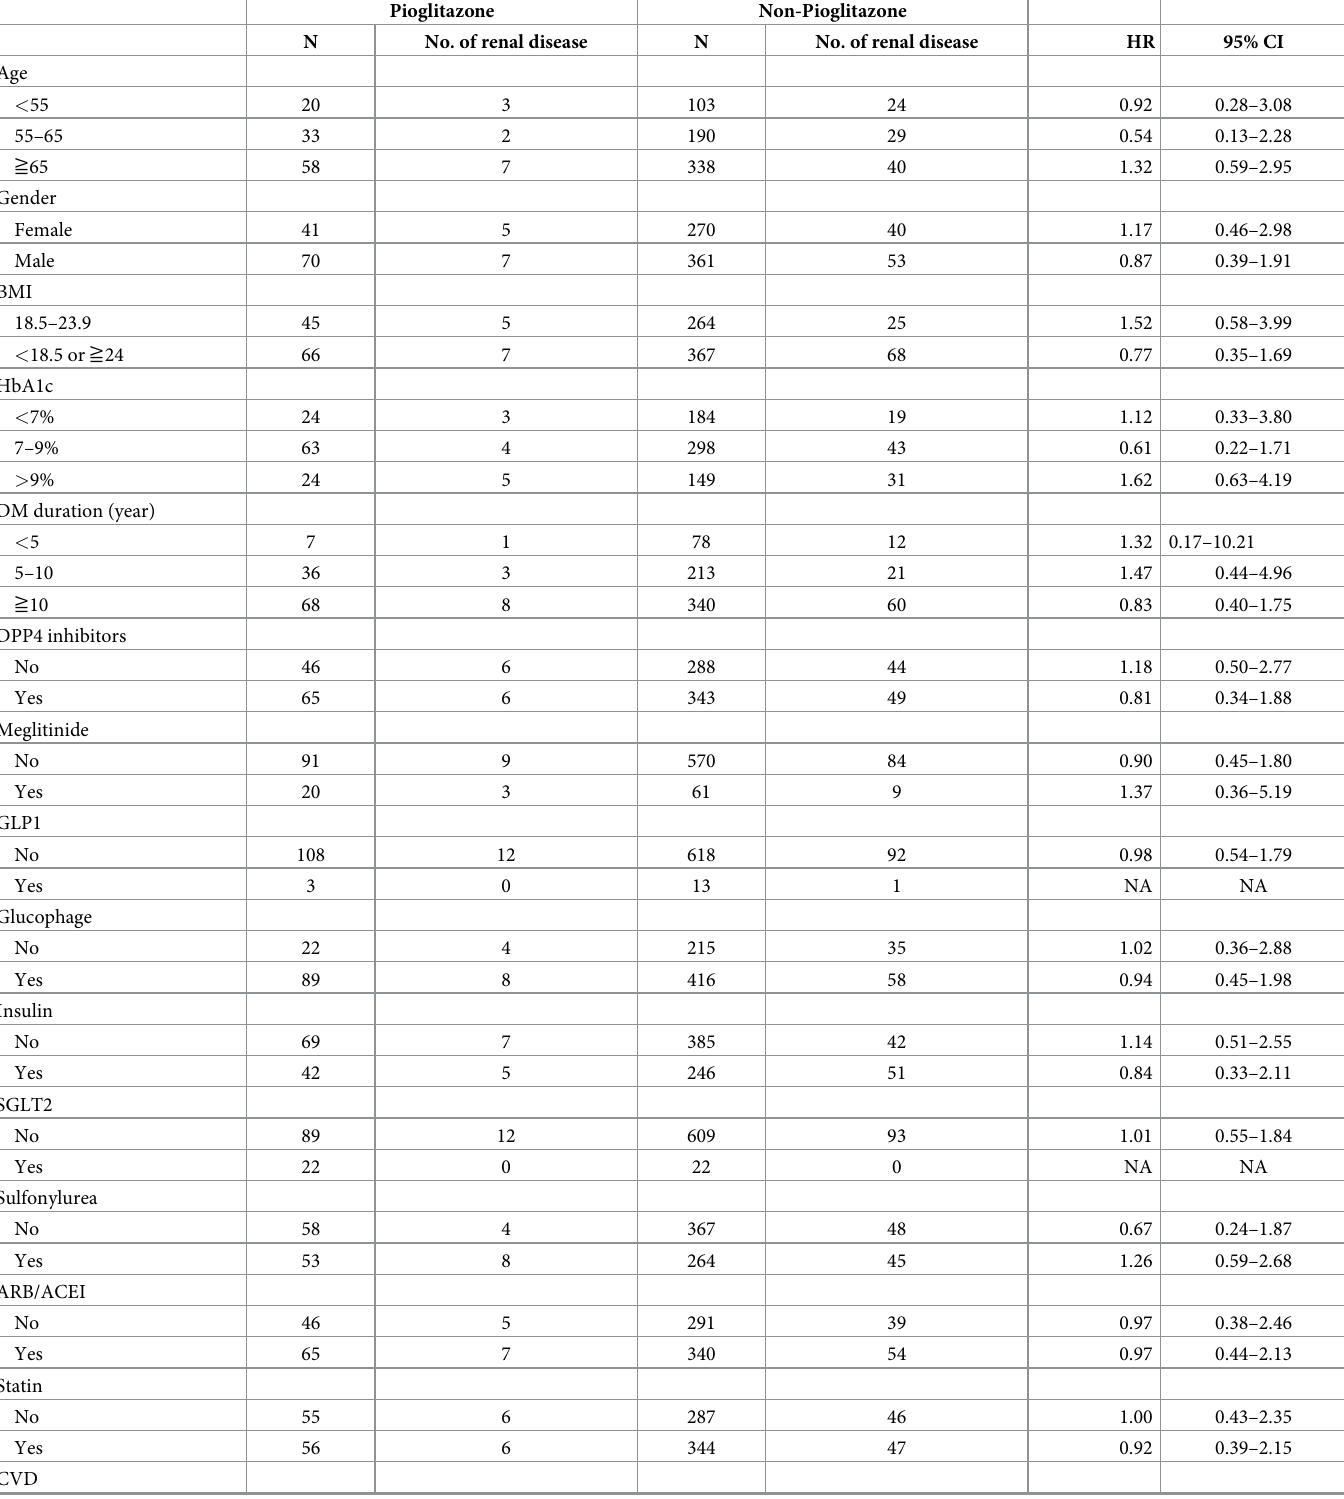
Table 3. Subgroup analysis of renal outcomes between Pioglitazone users and non-Pioglitazone